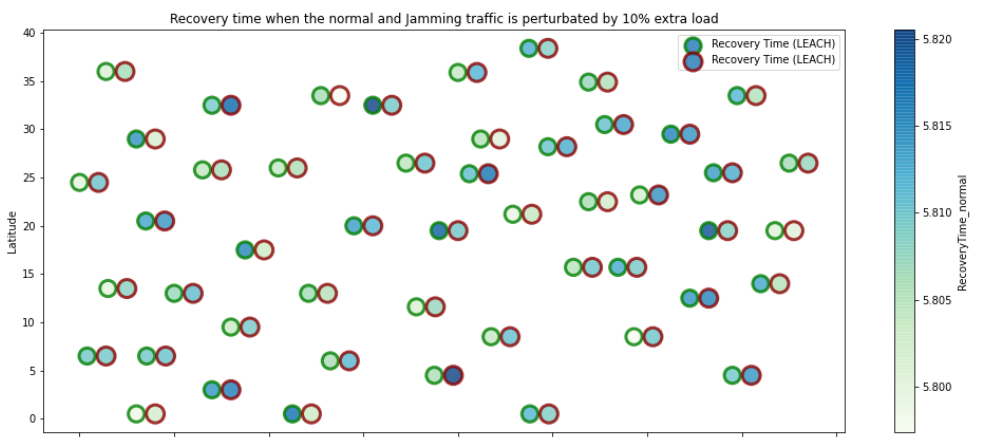
Figure 6. LEACH resilience under normal conditions and jamming.